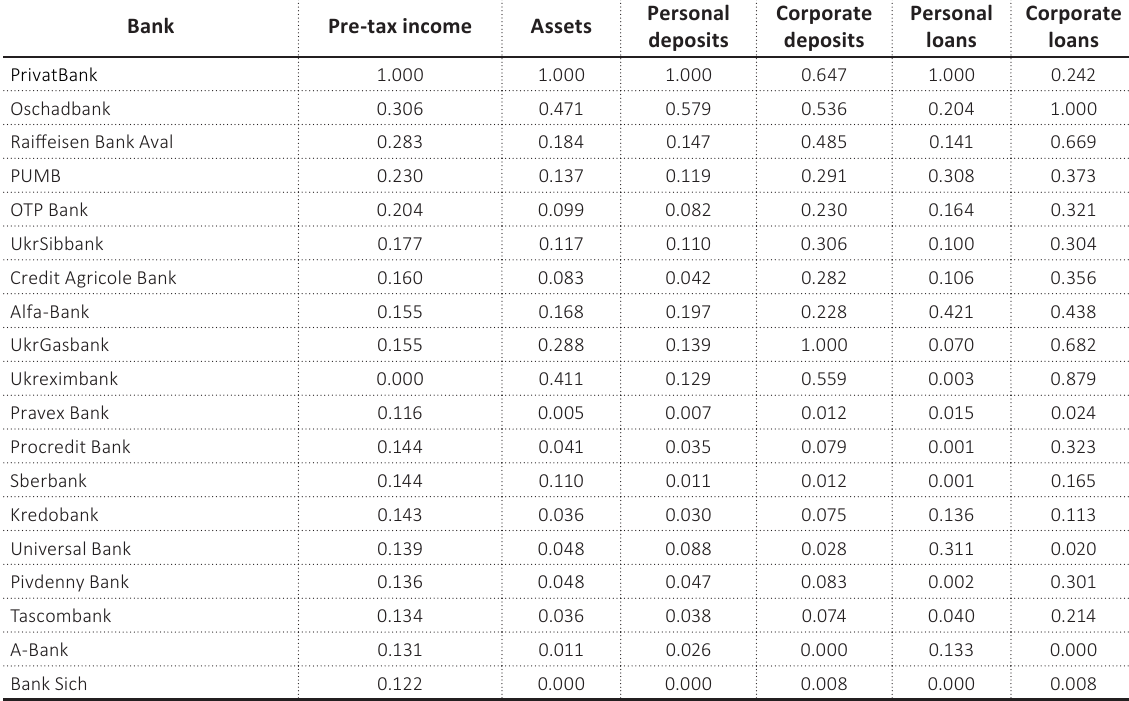
Table 1. Linear data transformation based on financial indicators designed to analyze the competitive capacity of Ukrainian banks